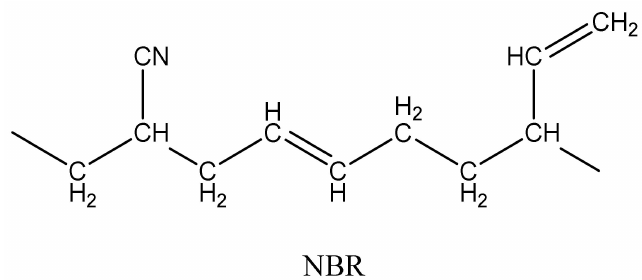
Scheme 4. The general structure of